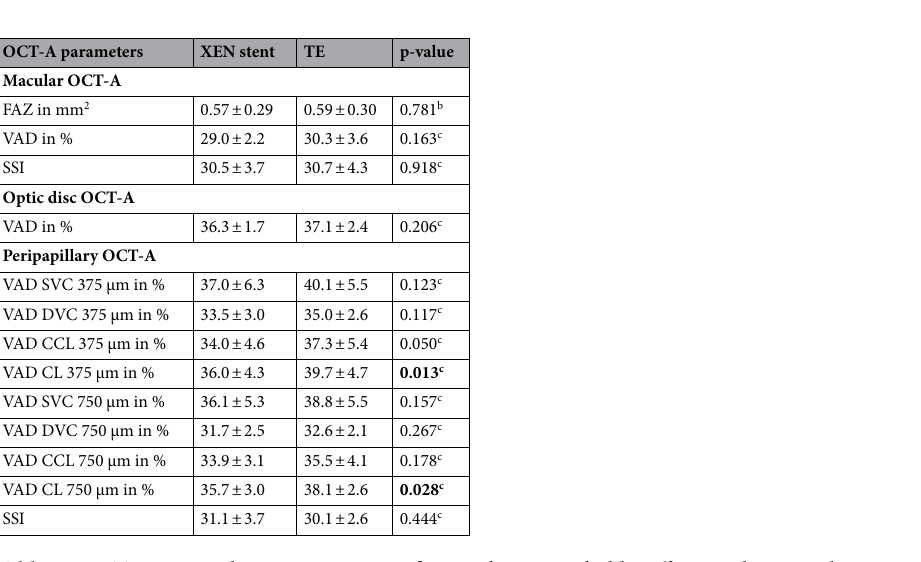
Table 3. OCT-Angiography parameters. Significant values are in bold. Differences between the groups are shown as mean ± standard deviation. FAZ foveal avascular zone, VAD vessel area density, SSI Signal Strength Index, SVC superficial vascular complex, DVC deep vascular complex, CCL choriocapillaris layer, CL chorioideal layer, 375 µm radius around optic disc, 750 µm radius around optic disc. a Chi-Quadrat test. b Mann-Whitney U test. c t